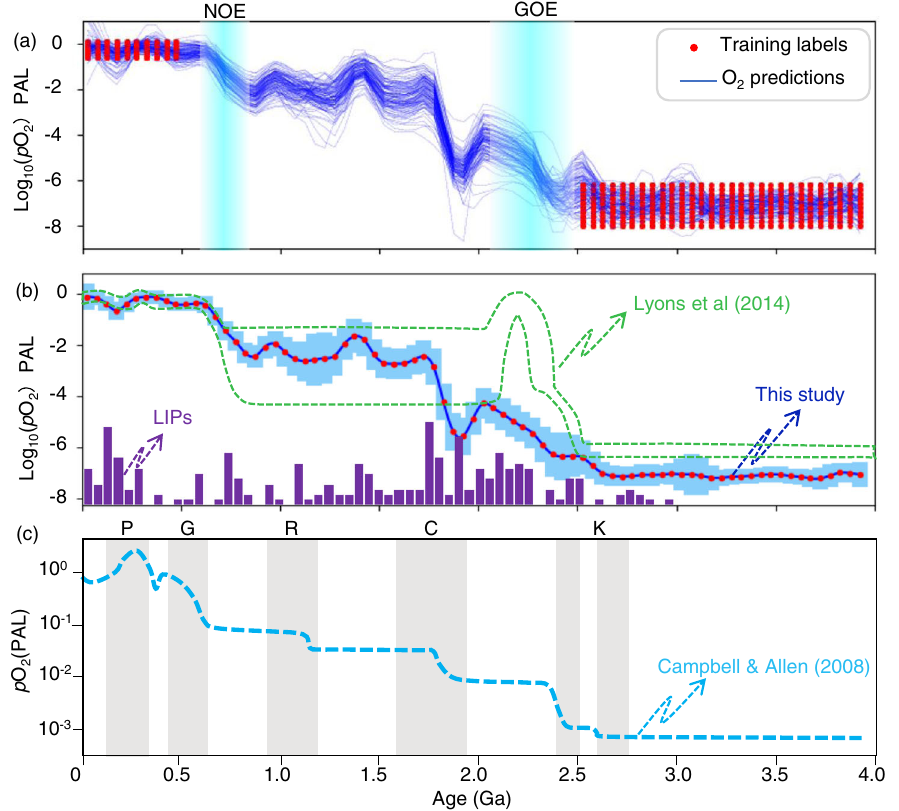
Fig. 5 | Quantitative prediction of atmospheric O 2 content using machine learning. a All curves of support vector regression (SVR) modeling of atmo- spheric O 2 content using global ma fi c igneous geochemistry data through Monte Carlo simulations ( n = 100), with random training label pairs selected pre-2.5Ga and post-0.5 Ga. b Estimated atmospheric O 2 variation through